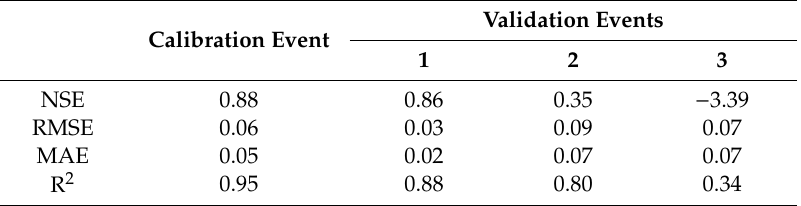
Table 4. Goodness-of-fit (using Manning’s n = 0.055, which provides the best calibration results) and predictive performance of the HEC-RAS model in simulating surface water height in the stream network within the Ribeira dos Cov õ es catchment during three separate storm events, based on four evaluation criteria (Nash–Sutcli ff e e ffi ciency (NSE), root mean square error (RMSE), mean absolute error (MAE) and coe ffi cient of determination (R 2 )).